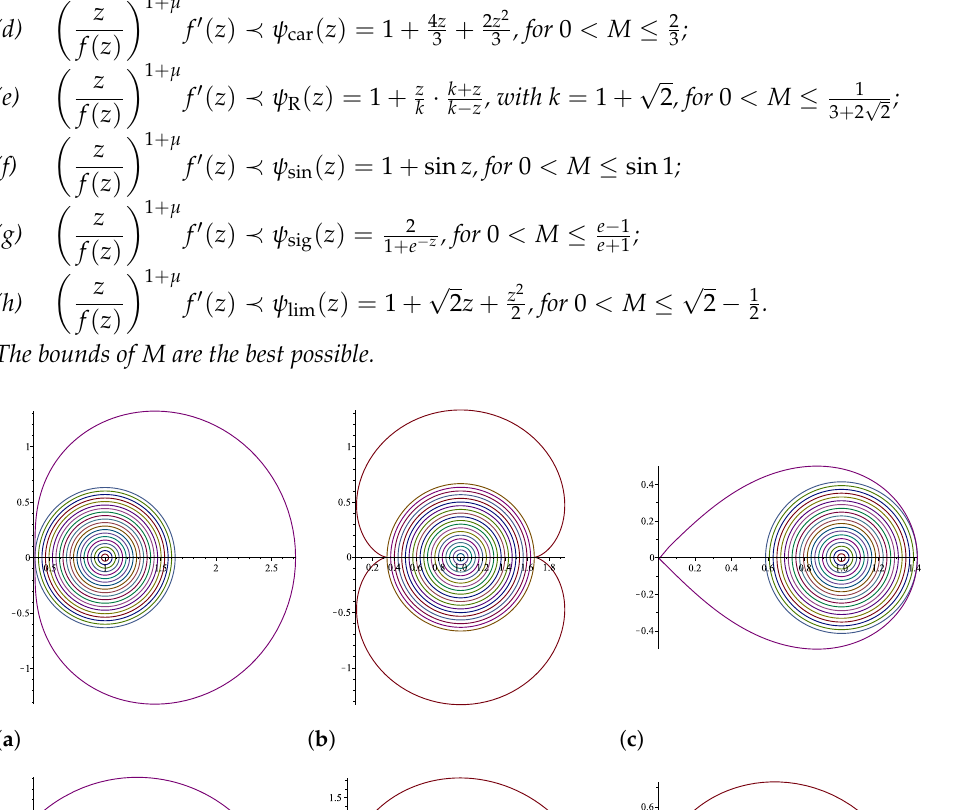
. e . ( c ) Boundary curve of ψ L ( D ) and q M ( D ) for √ e 2. ( e ) Boundary curve of ψ car ( D ) √ . ( g ) Boundary curve 3 + 2 2 . √ e + 1 2 − 1 2